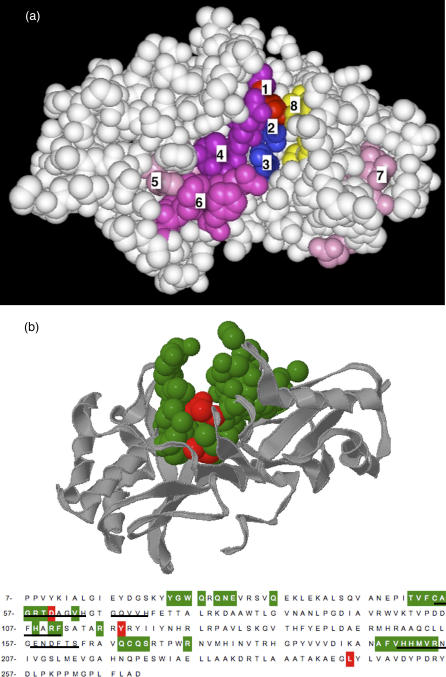
SPs Occurrence on a Spatial Structure of an Enzyme(A) 3-D display of enzyme P07649 (PDB code 1DJ0), belonging to 5.4.99.12, showing (1) an active site D at sequence location 60; (2) a binding site Y at location 118; (3) a binding site L at location 245. The active site is common to two SPs (4) containing (CAGRT(D)AGVH). Other shown SPs are (5) GQVVH at locations 67–71; (6) FHARF at 107–111, known to be a tentative RNA-binding peptide; (7) ENDFTS at 157–163; and (8) HMVRNI at 201–207, sharing a pocket with the active and binding sites. QVVH and ENDFTS belong to SP3, all other peptides belong to SP4.(B) A different display of the same enzyme focuses on the pocket containing the active site. The relevant section of the sequence is shown, with red residues signifying active and binding sites, green residues corresponding to other amino acids residing in the pocket, and underlined residues corresponding to SPs.